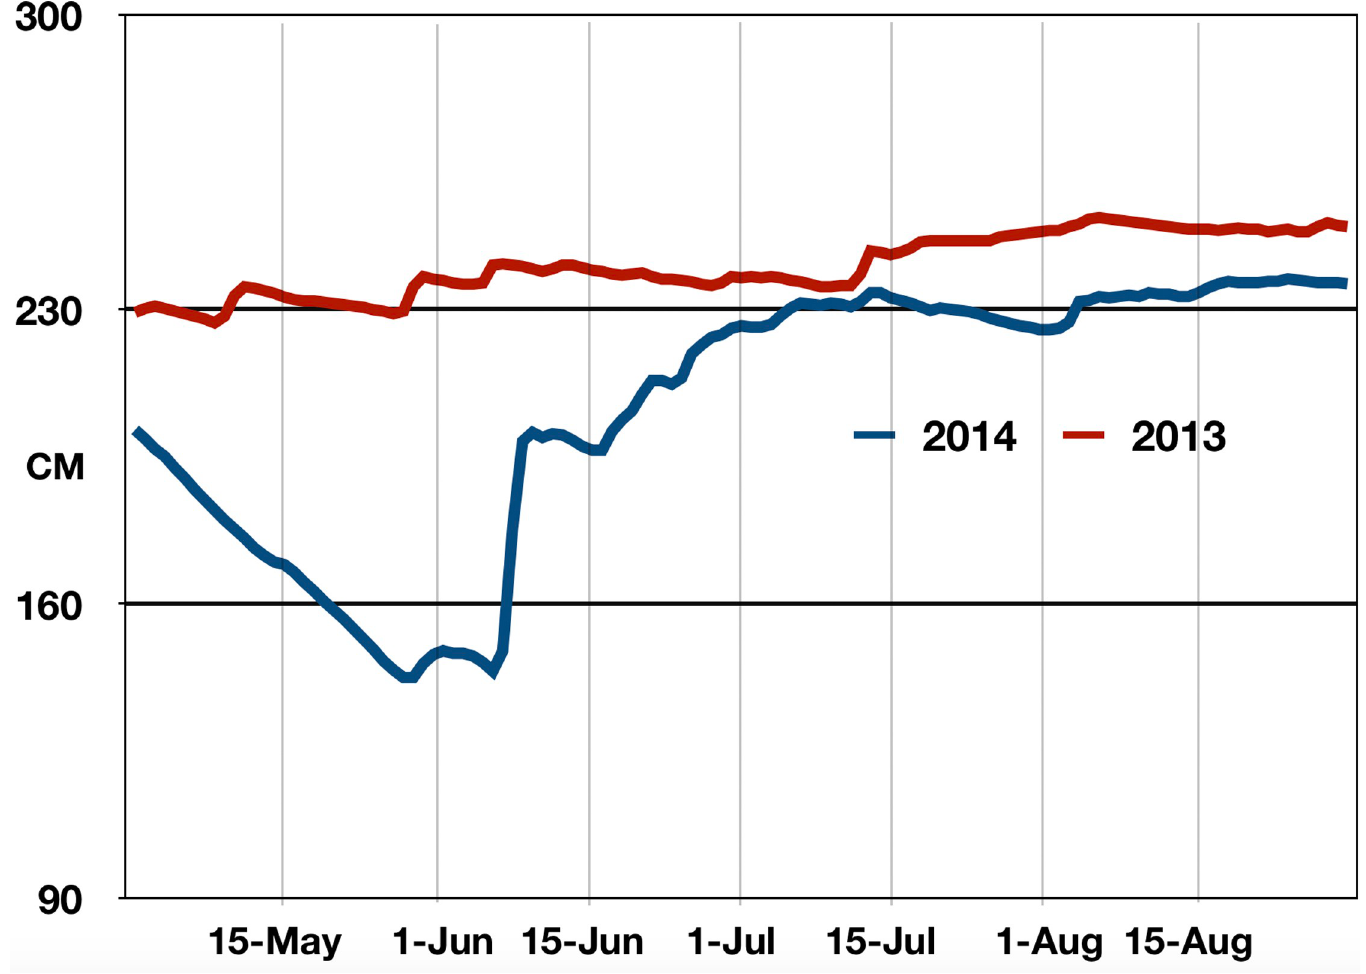
Fig 3. Water level. Summer water levels at Loop Road hydrologic station in 2013 and 2014 [33].